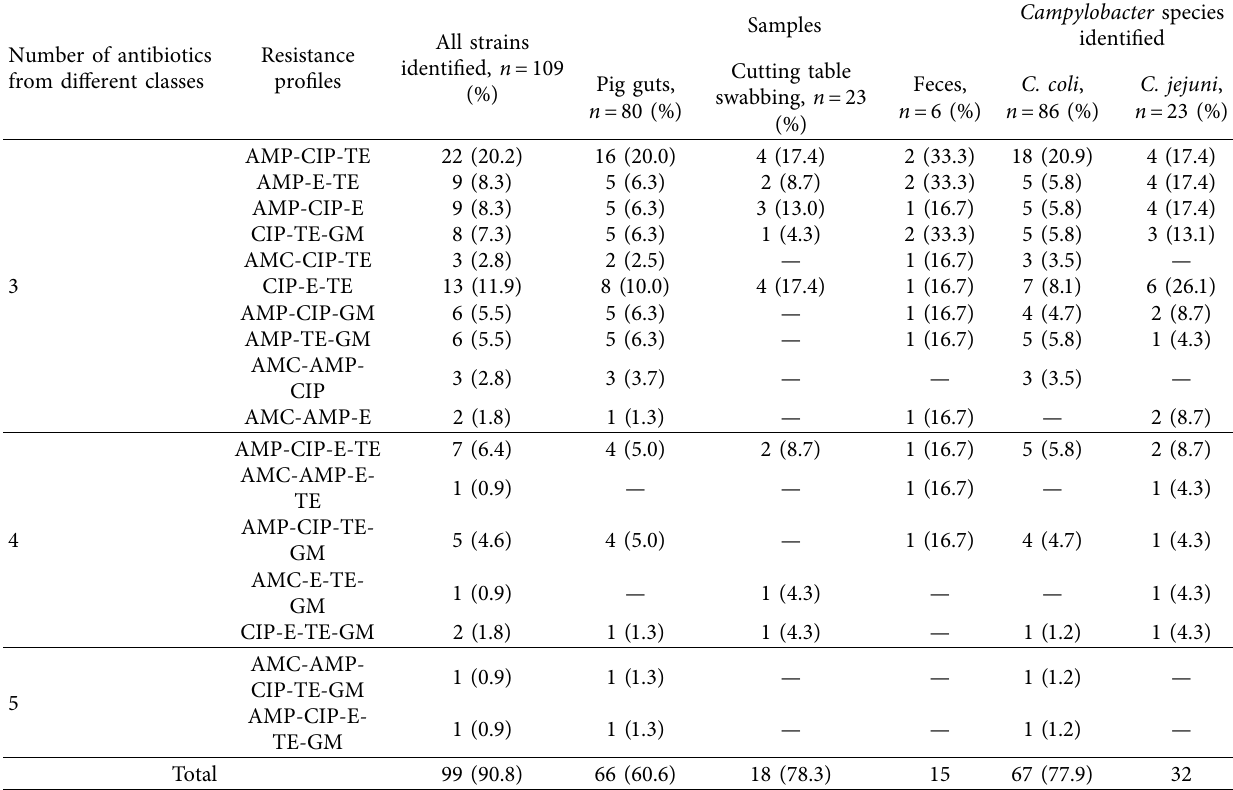
Table 6: Profiles of multidrug-resistant strains identified according to samples and Campylobacter species identified. Number of antibiotics from different